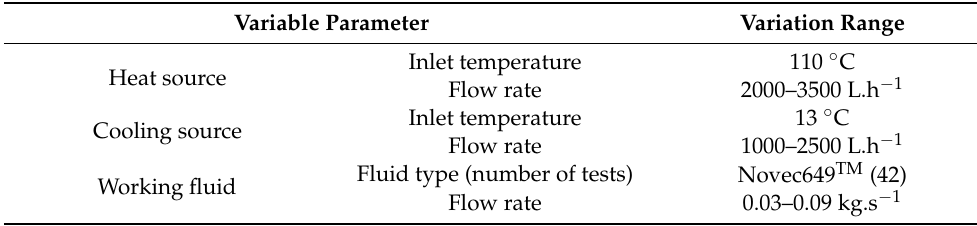
Table 3. Variable parameter and variable range (campaign 1).